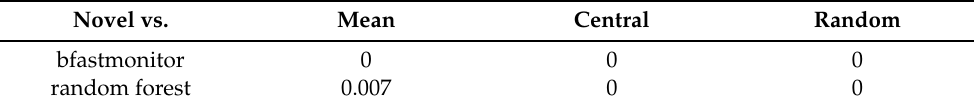
Table 2. Wilcoxon paired signed-ranks test p values lower than the significance level α = 0.05 show that the novel downsampling method is consistently better than the alternatives. The p -values marked as 0 are approximations up to the ninth decimal. Novel vs. Mean Central Random bfastmonitor 0 0 0 random forest 0.007 0 0